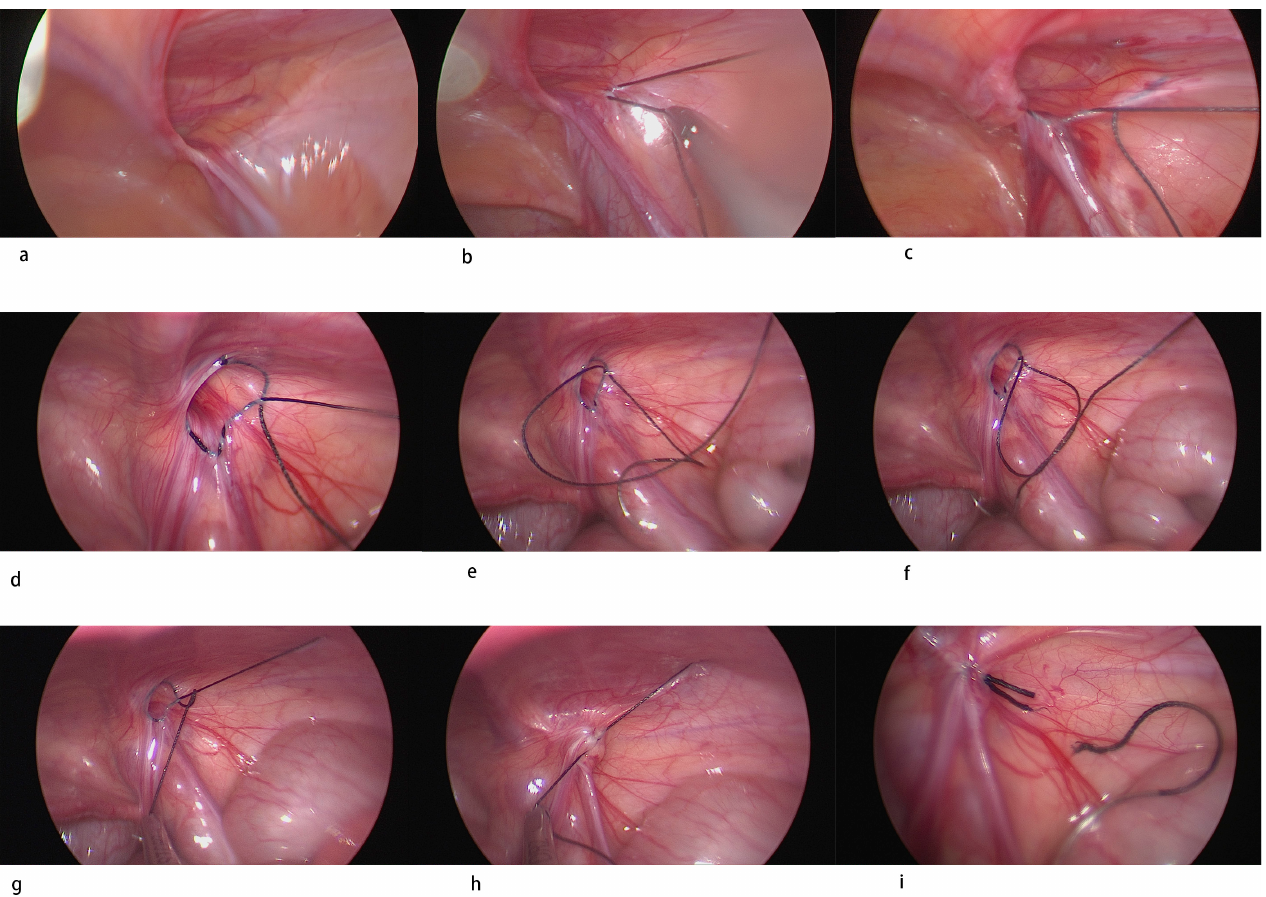
Figure 2. Step by step single-incision laparoscopic herniorrhaphy: ( a ) examine bilaterally; ( b , c ) skip the vas deferens and the spermatic vessels under tension; ( d ) complete intracorporeal skipped purse string suture; ( e ) pull the exterior string inside and make a cross; ( f ) put the needle into the circle and make a half stitch; ( g , h ) tie the knot cautiously so as not to curl the cord in; ( i ) cut the suture.